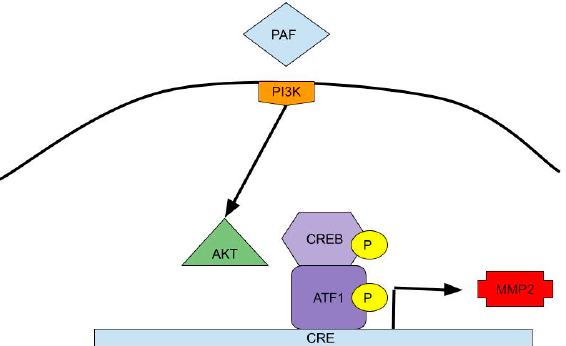
Figure 2. PAF has been linked to an increase in MMP2 and MMP9 via the phosphorylation of CREB and subsequent ATF1 activation. and subsequent ATF1